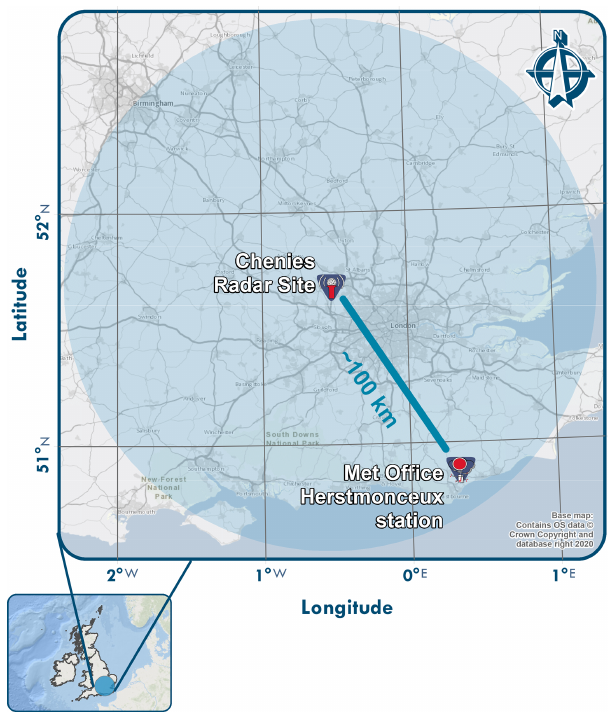
Figure 1. Location and coverage (on short pulse, SP, mode) of the Chenies weather radar and location of the Herstmonceux ra- diosonde station. Source: base map contains OS data. ©Crown copyright and Crown database right, 2020. Table 1. Chenies radar